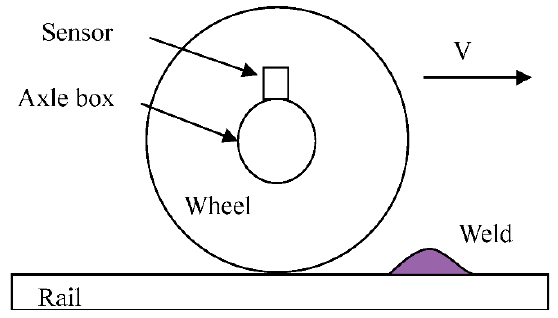
Figure 2. Installation of the acceleration sensor on the axle box.